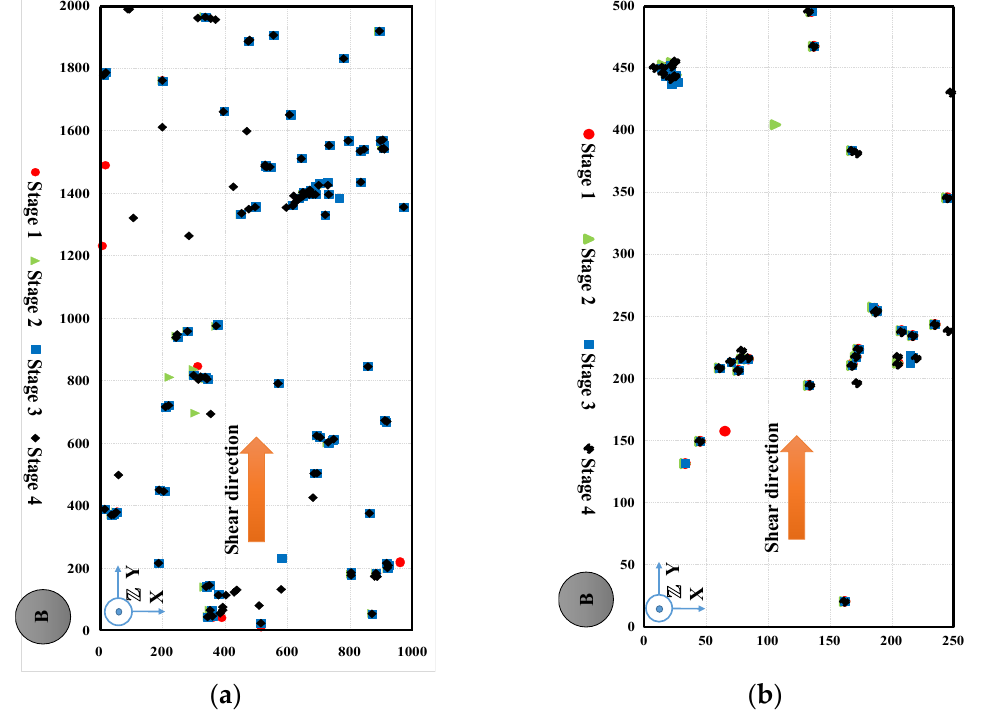
Figure 6. Damage mapping after four shearing stages on the bottom surface of the sample mapped by a ruler: ( a ) large sample and ( b ) medium sample. The colored dots show damaged areas in the different stages of the shear tests.